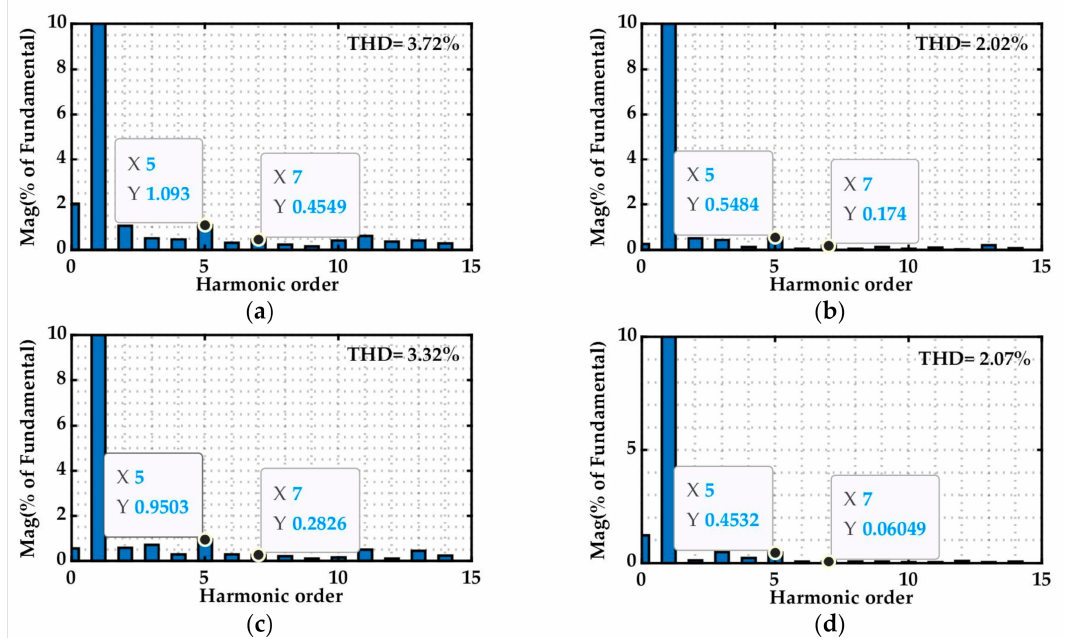
Figure 12. Fast Fourier transform (FFT) results of phase A current at 150 r/min and 1 N · m load. ( a ) Compensation for PMSM FOC system with conventional DM–CZD. ( b ) Compensation for PMSM FOC system with proposed DP–CZD. ( c ) Compensation for current predictive control of PMSM with conventional DM–CZD. ( d ) Compensation for current predictive control of PMSM with proposed